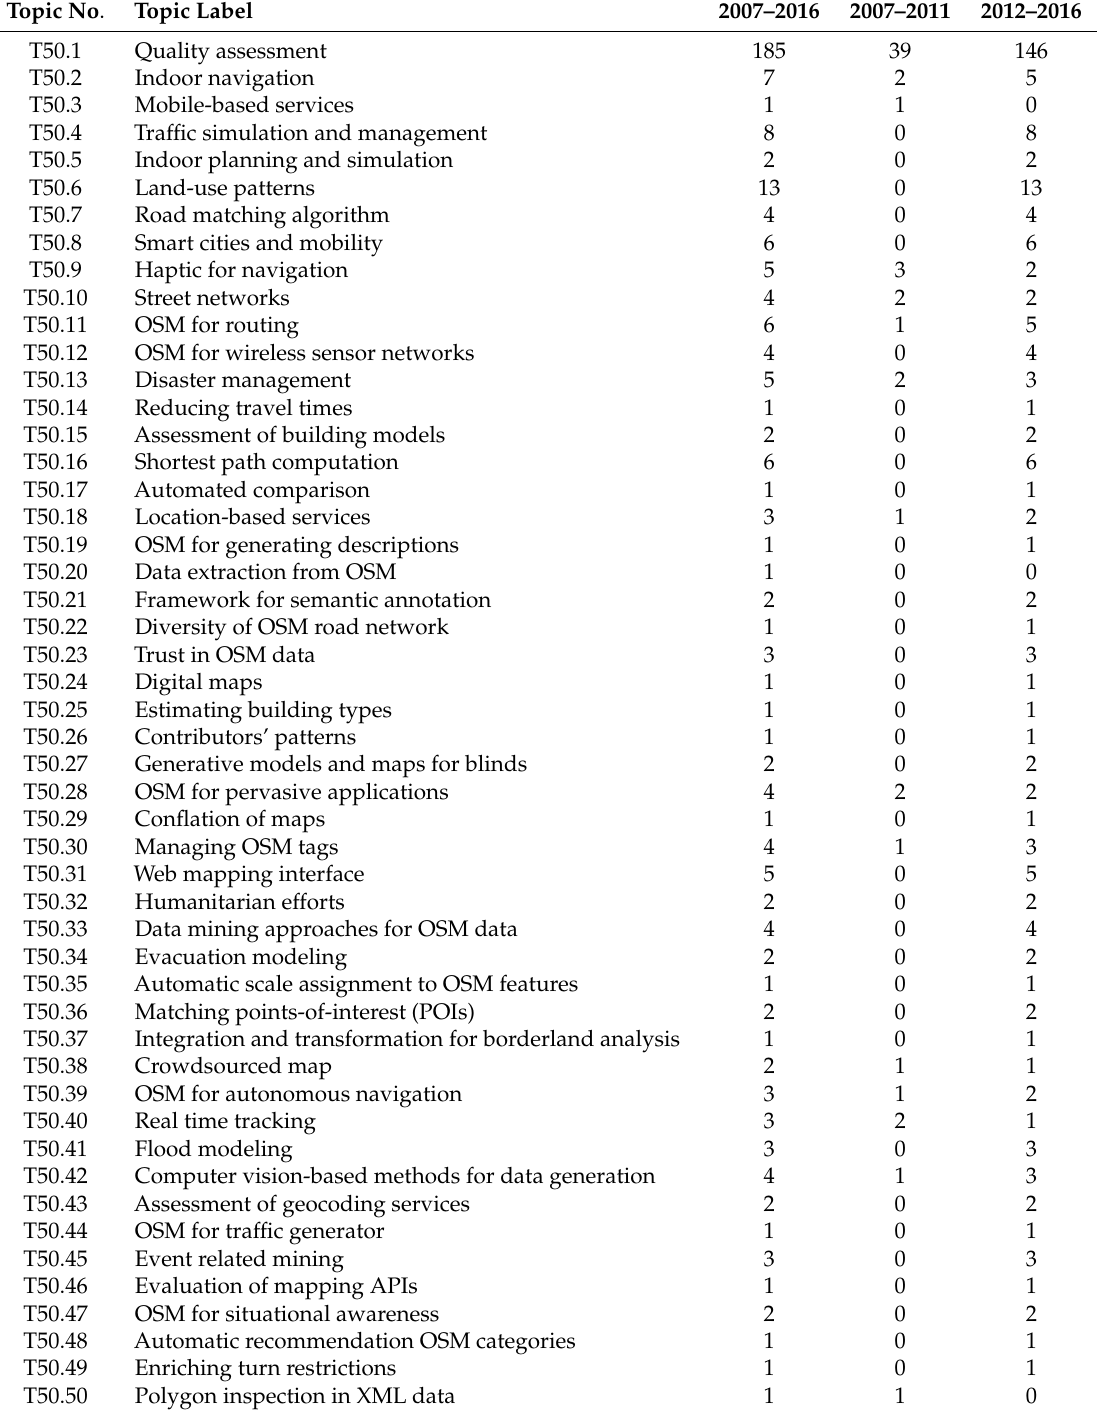
Table 8. Research trends for